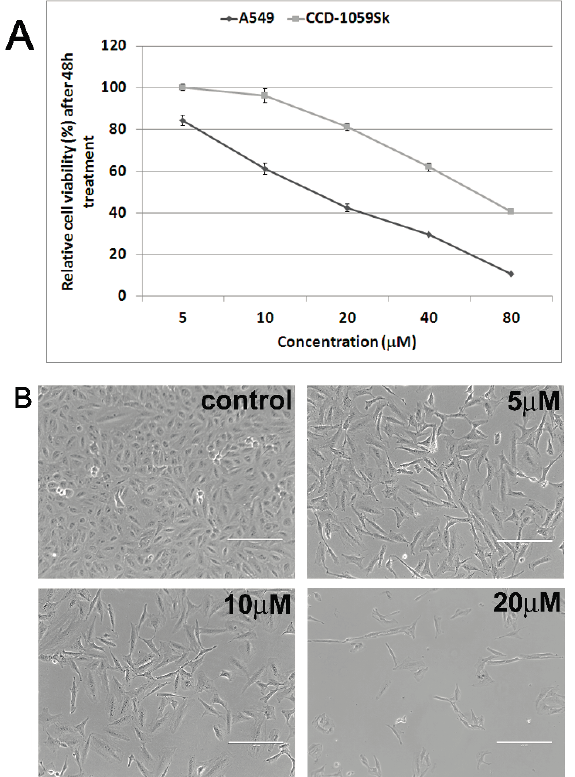
Figure 1. ( A ) Cell viability profile of A549 and CCD-1059Sk cells after treatment with 7-epiclusianone for 48 h; ( B ) Phase contrast microscopy images showing morphological aspect of A549 cells. 7-epiclusianone treatment clearly affected cell density in a concentration-dependent manner and induced cell morphology changes. Scale bars: 200